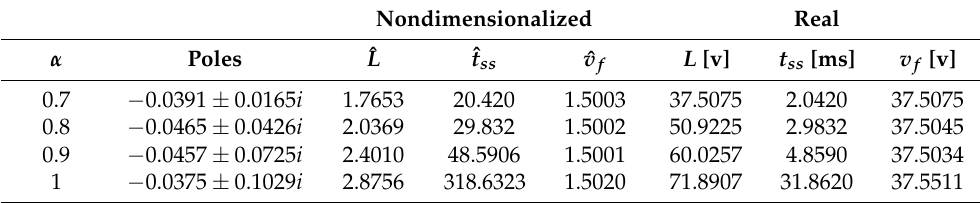
Table 2. Electrical characteristics of the fractional-order Buck-Boost Converter while varying α